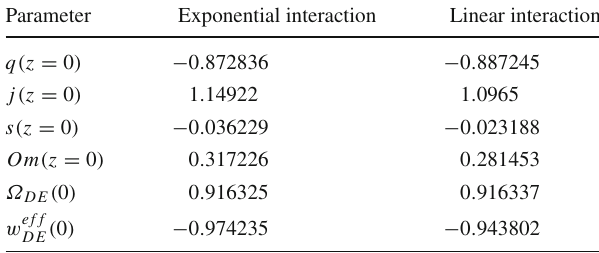
Fig. 11 Variation of dark energy variables, Ω H (left), deceleration parameter q (right) and the effective EoS parameter w ef f without interaction. The red curve corresponds to the non-interacting scenario and the blue and black curves correspond to η = ± 0 . 09 and α = 0 . 9 respectively